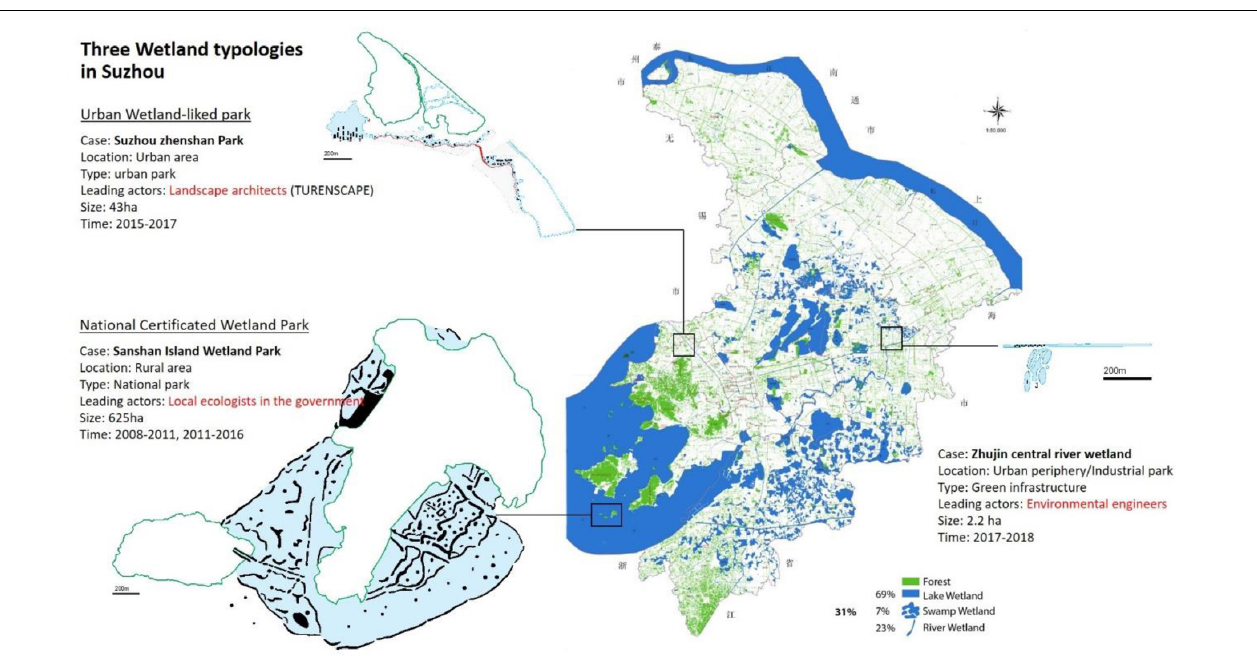
FIGURE 2 | Location map of three case studies in Suzhou, Source: made by author based on the Map of Suzhou Wetland resources (Suzhou Wetland Protection Management Station [SWPMS],